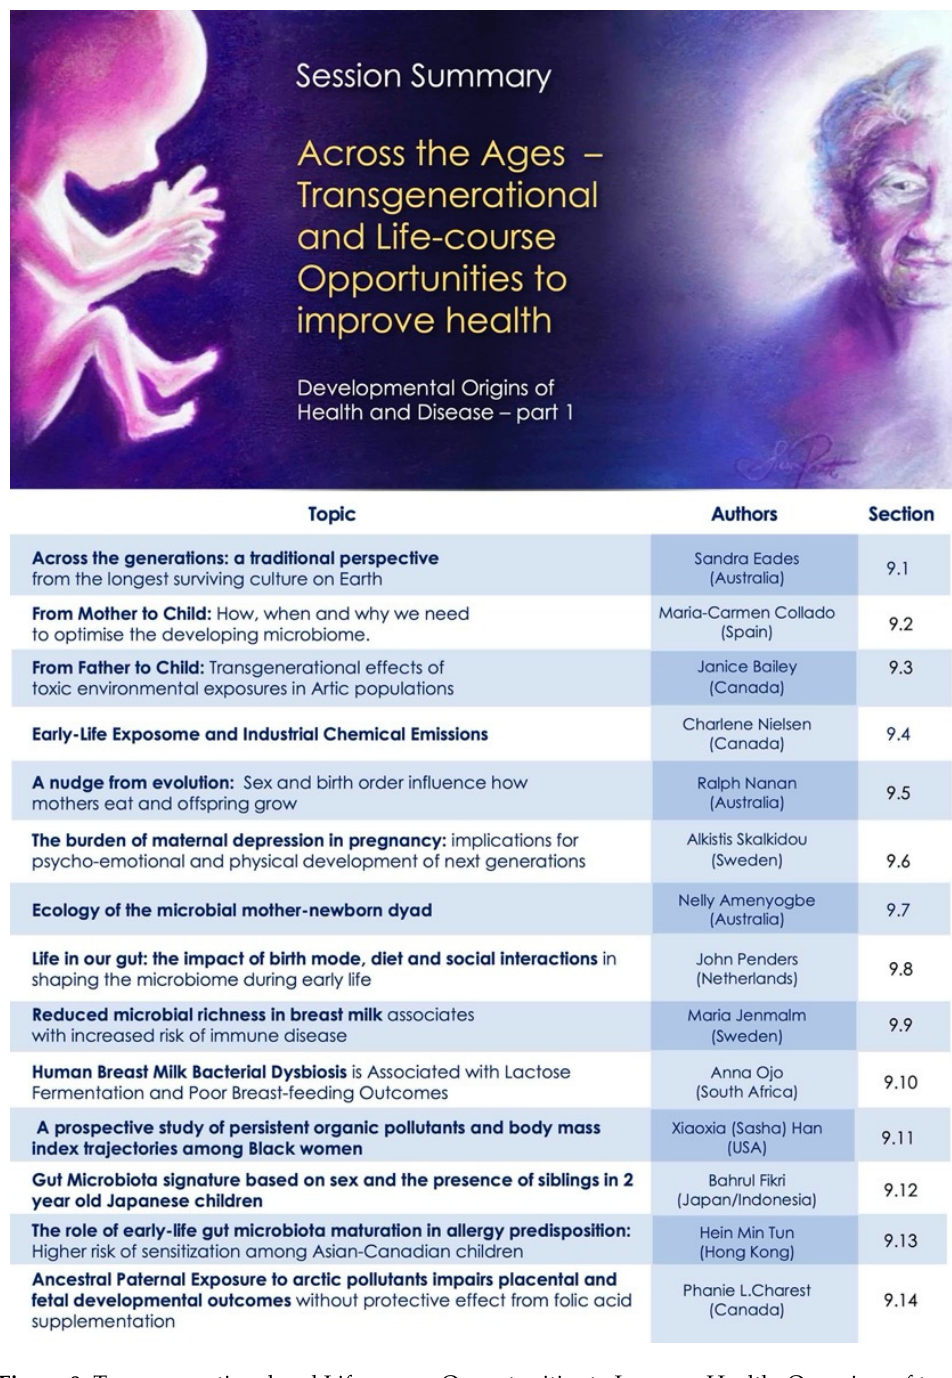
Figure 8. Transgenerational and Life-course Opportunities to Improve Health: Overview of topics and speakers in the session on developmental ecology (Part